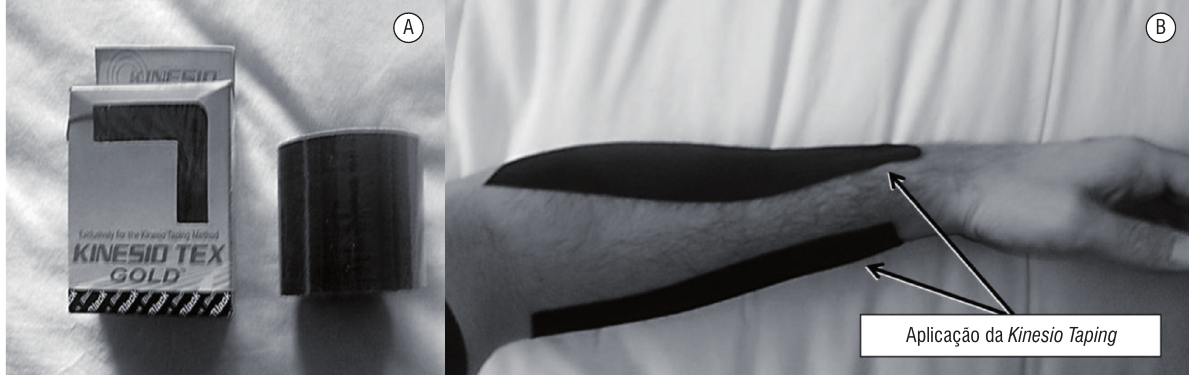
Figura 2 - Bandagem Kinesio Taping (A) e respectivo modo de aplicação em “ I ” sobre flexores e extensores de punho (B) Fonte: Dados da